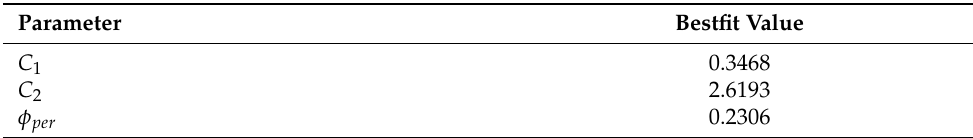
Table 1. Fit values of the permeability – porosity correlation.